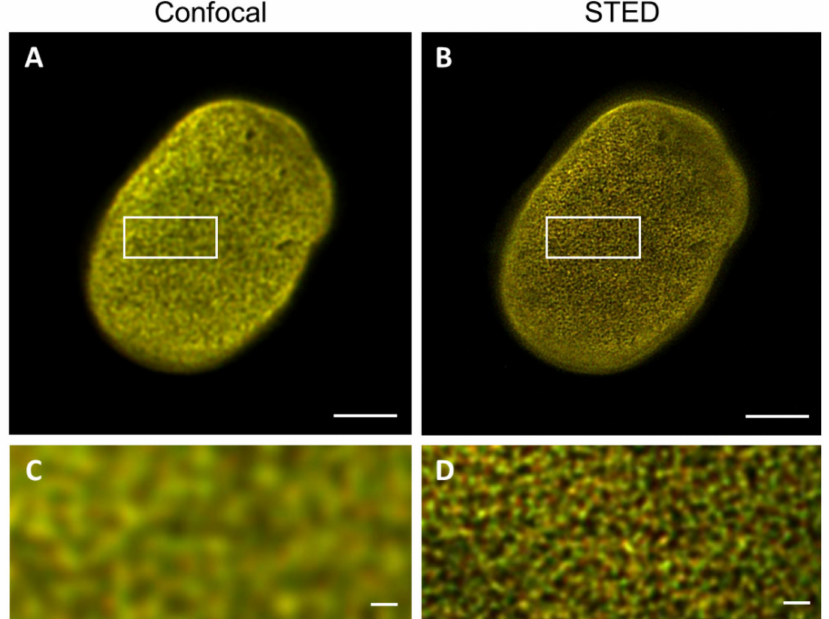
Figure 8. Merged images of the top of the nucleus, visualizing the lamin A/C (red) and lamin B1 (green) network in nHDF cells. ( A ) Confocal microscopy image of nHDF stained with antibodies against lamin A/C and B1. ( B ) STED microscopy image of nHDF stained with antibodies against lamin A/C and B1. ( C , D ) Higher magnification (4.3 × ) of ROIs in ( A , B ). Scale bars: 5 µ m.